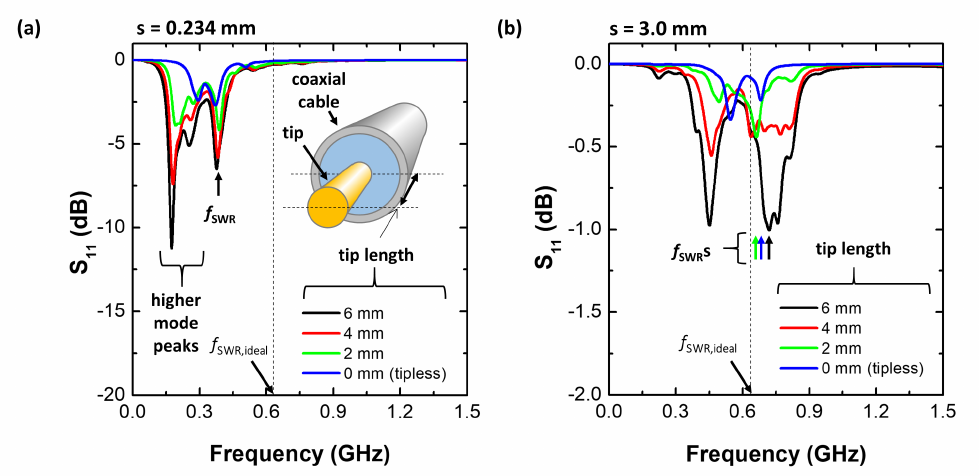
Figure 5. S 11 spectra with various tip lengths at a sheath width of ( a ) 0.234 mm and ( b ) 3.0 mm, electron density of 1 × 10 10 cm − 3 , and pressure of 100